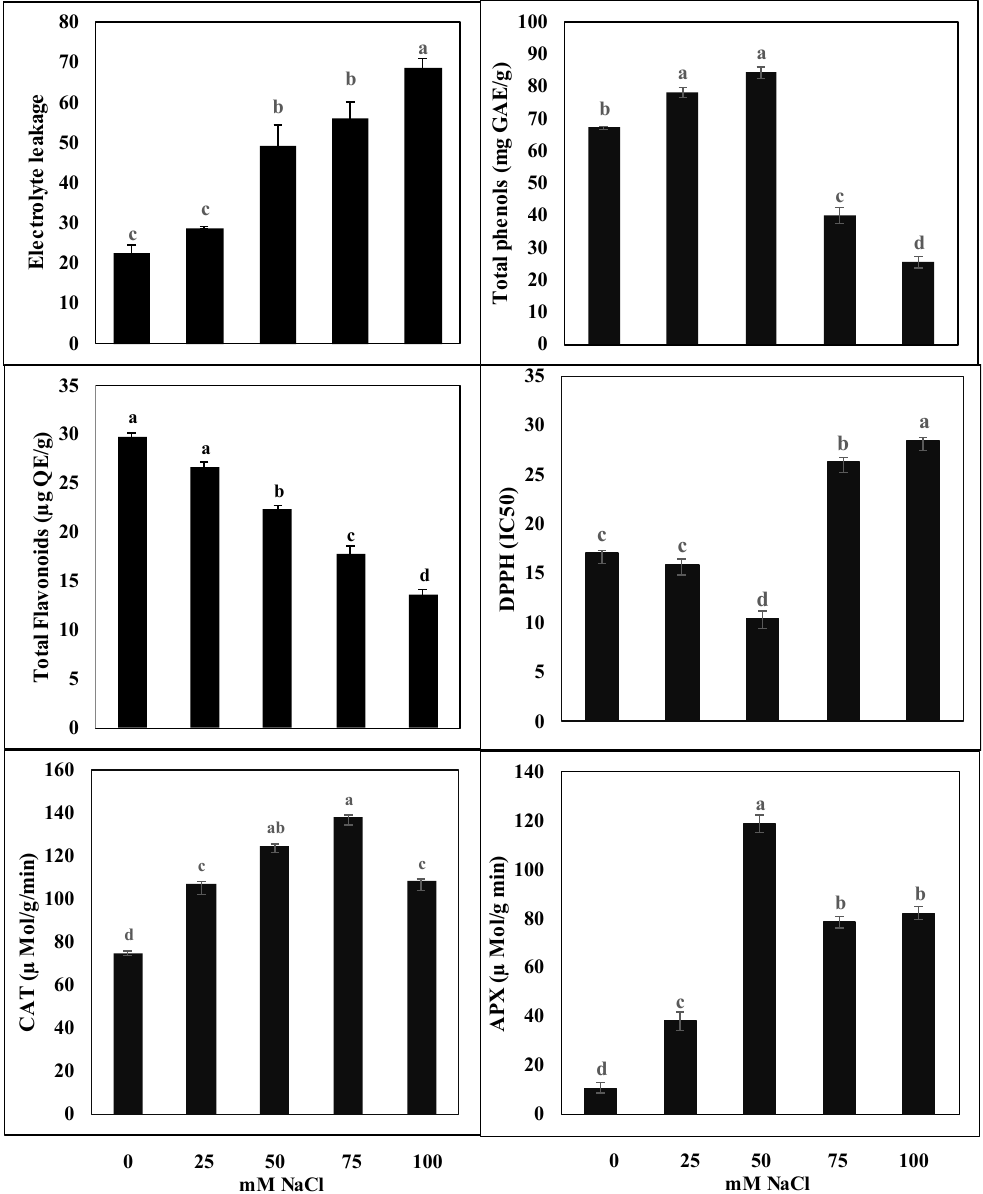
Figure 1. The effect of salinity stress on physiological and biochemical parameters measured in the greenhouse. Means along with the same letter are not significantly different at 5% significance level ( p ≤ 0.05). Table 3. ANOVA of salinity stress effect on physiological parameters measured in the greenhouse and in vitro. Mean of Squares Source of G r ee nh o u